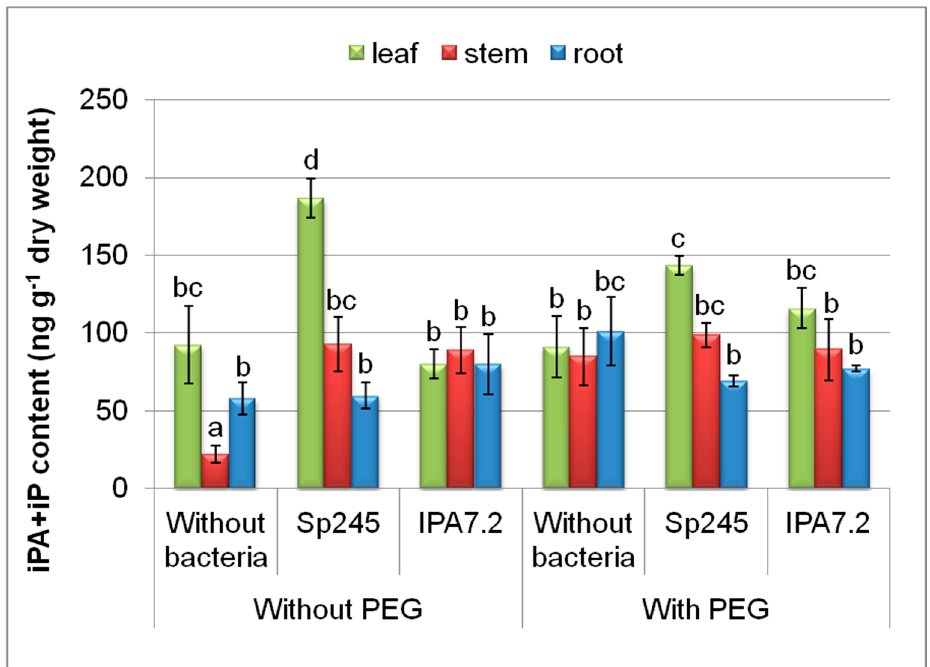
Figure 4. The effect of PEG and microplants’ inoculation with bacterial strains ( A. brasilense Sp245 and O. cytisi IPA7.2) on the content of isopentenyl derivatives (isopentenyl adenine (iP) and isopentenyl adenosine (iPA)) in organs of potato plants cultivated in vitro. Means ± SE ( n = 6) marked with similar Latin letters do not differ significantly according to the LSD-test ( p ≤ 0.05).